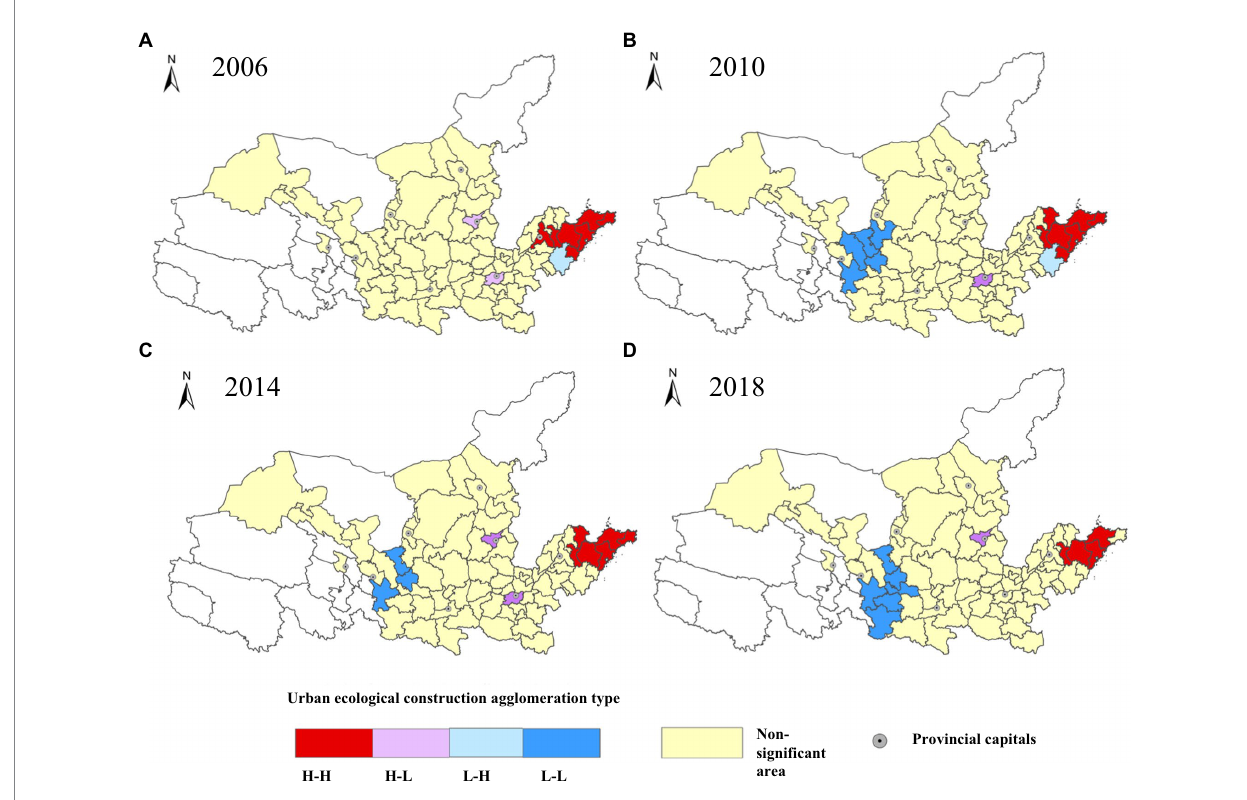
FIGURE 4 LISA map showing the quality of urban ecological construction in the Yellow River